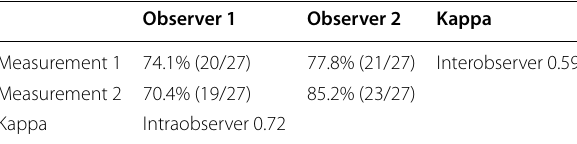
Table 2 Percentage of subjects with adequately positioned